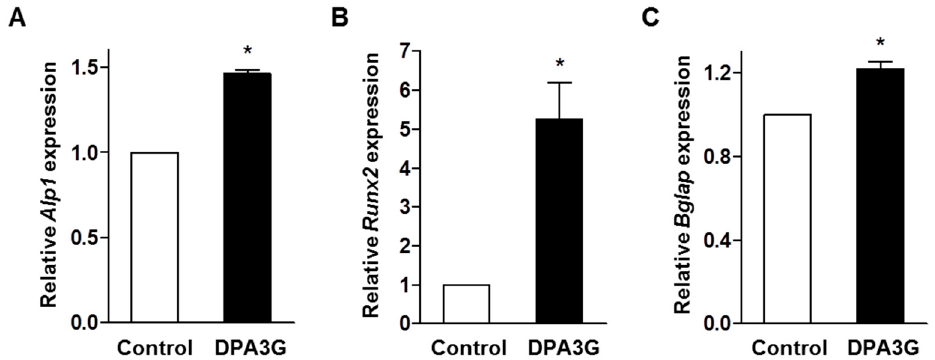
Figure 3. Effects of (1 ′ R ,2 ′ S ,5 ′ R ,8 ′ S ,2 ′ Z ,4 ʹ E )-dihydrophaseic acid 3 ′ - O - β - D -glucopyranoside (DPA3G) on the mRNA expression levels of osteoblast differentiation markers in preosteoblast MC3T3-E1 cells. After induction of osteoblast differentiation, cells were treated with 5 µ g/mL of DPA3G fraction for 3 days and then total RNA of the cells was extracted. The mRNA expression levels of Alpl (alkaline phosphatase, ALP) ( A ); Runx2 (runt-related transcription factor 2, Runx2) ( B ); and Bglap (bone gamma carboxyglutamate protein, Osteocalcin) ( C ) genes were assessed by quantitative reverse-transcription polymerase chain reaction (qRT-PCR) and then normalized to Gapdh (glyceraldehyde 3-phosphate dehydrogenase) mRNA expression. Control: non-DPA3G-treated cells. *: p < 0.05 vs. Control (Student’s t -test). All of the experiments were repeated three times.